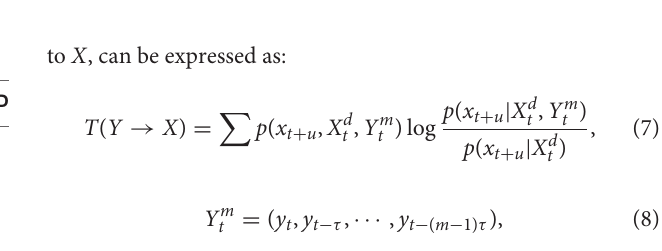
FIGURE 4 | The comparisons of the node removal and the edge removal method in exploring potential information of directed networks. (A) Directed network C. (B) Directed network D. (C) The varying curves of the average clustering coefficient with the times of node removal. (D) The varying curves of the network efficiency with the times of node removal. (E) The varying curves of the average clustering coefficient with the times of receiving-edge removal. (F) The varying curved of the network efficiency with the times of receiving-edge removal. (G) The varying curves of the average clustering coefficient with the times of sending-edge removal. (H) The varying curves of the network efficiency with the times of sending-edge removal.